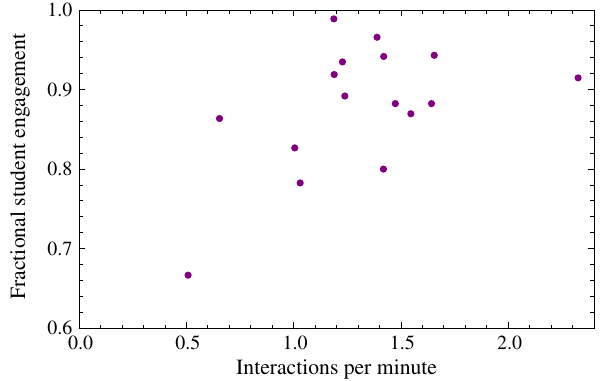
FIG. 2. Fractional student engagement versus number of TA – student interactions per minute during the student working period in the lab. The frequency of interactions is positively correlated with engagement: r ð 14 Þ ¼ 0 . 52 .